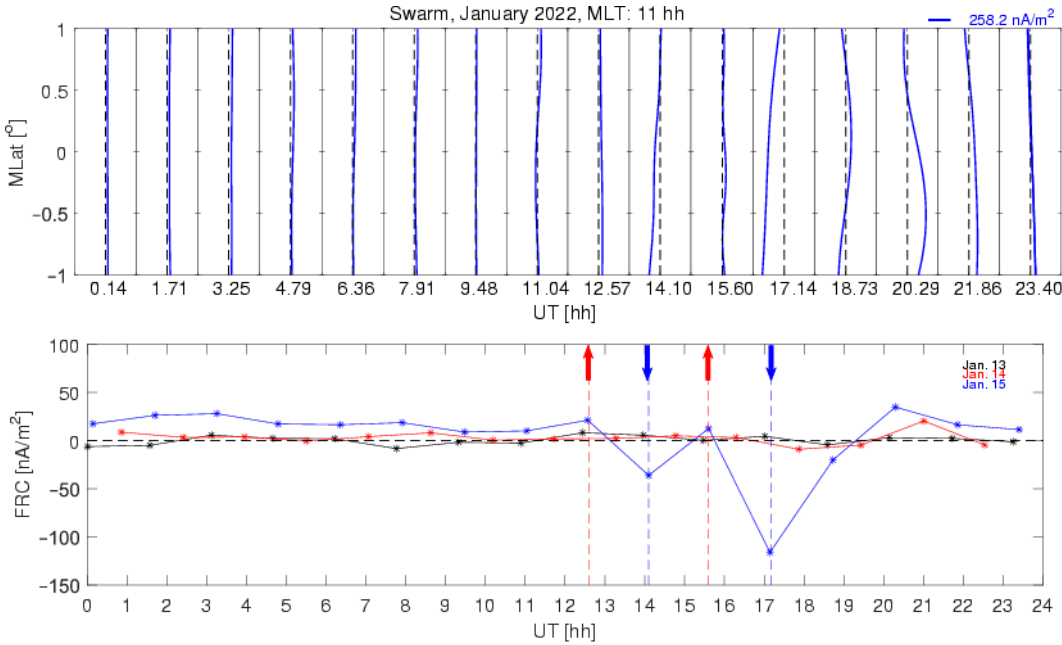
Figure 2. Top panel : Latitudinal variations in the normalized FRC within ±1° MLat observed by dual Swarm A and C satellites on 15 January 2022. The vertical dashed lines indicate the zero current, while the positive (negative) FRC incidents deviate to the right (left). The x-axis range is from − 1 to 1. Bottom panel : Temporal variations in the latitudinal averaged FRC during 13–15 January. Black curve is on 13 January, red curve is on 14 January, and blue curve is on 15 January. Positive values denote the radially upward FRC, while negative value denote the radially downward FRC. The red arrows and vertical dashed lines denote the radially upward FRC on 15 January, while the blue arrows and vertical dashed lines denote the radially downward FRC on 15 January. 4. Discussion One of the possible reasons for the strong FRC density identified in this work might have been the F-region magnetic zonal winds. Note that we are using the magnetic zonal wind in the present work. Figure 3 shows the ICON tracks and altitudinal distribution of the MIGHTI wind observations obtained during four subsequent orbits from 11:30 to 17:30 UT. The Tonga volcanic eruption occurred around − 20.54° GLat, − 175.38° GLon at 04:15 UT. The estimated eruption wave-front location is shown in green curves. The ICON and Swarm orbit tracks are also shown on the map. Although the ICON satellite flies at a higher latitude than the Swarm satellites, both the ICON and Swarm satellites are located at nearly the same great-circle distances from the eruption center, that is, nearly 17,000 km in Figure 3a, 13–15,000 km in Figure 3b, 11–13,000 km in Figure 3c, and 9–11,000 km in Figure 3d (see the green curves in the figure). In addition, the altitude map of ICON- monitored winds covers the longitudinal coverages of the Swarm satellites in the daytime (around 12 MLT). ICON cannot measure neutral wind above 300 km altitude. However, the F region neutral wind pattern might not change too much between 300 and 400 km altitudes due to the air viscosity [13]. A strong eastward wind above 250 km altitude approaching − 30° GLon around 11– 12 MLT (Swarm A longitude) can be seen in Figure 3c, followed by a strong westward wind above 250 km altitude, as shown in Figure 3d. Another pair of strong westward and